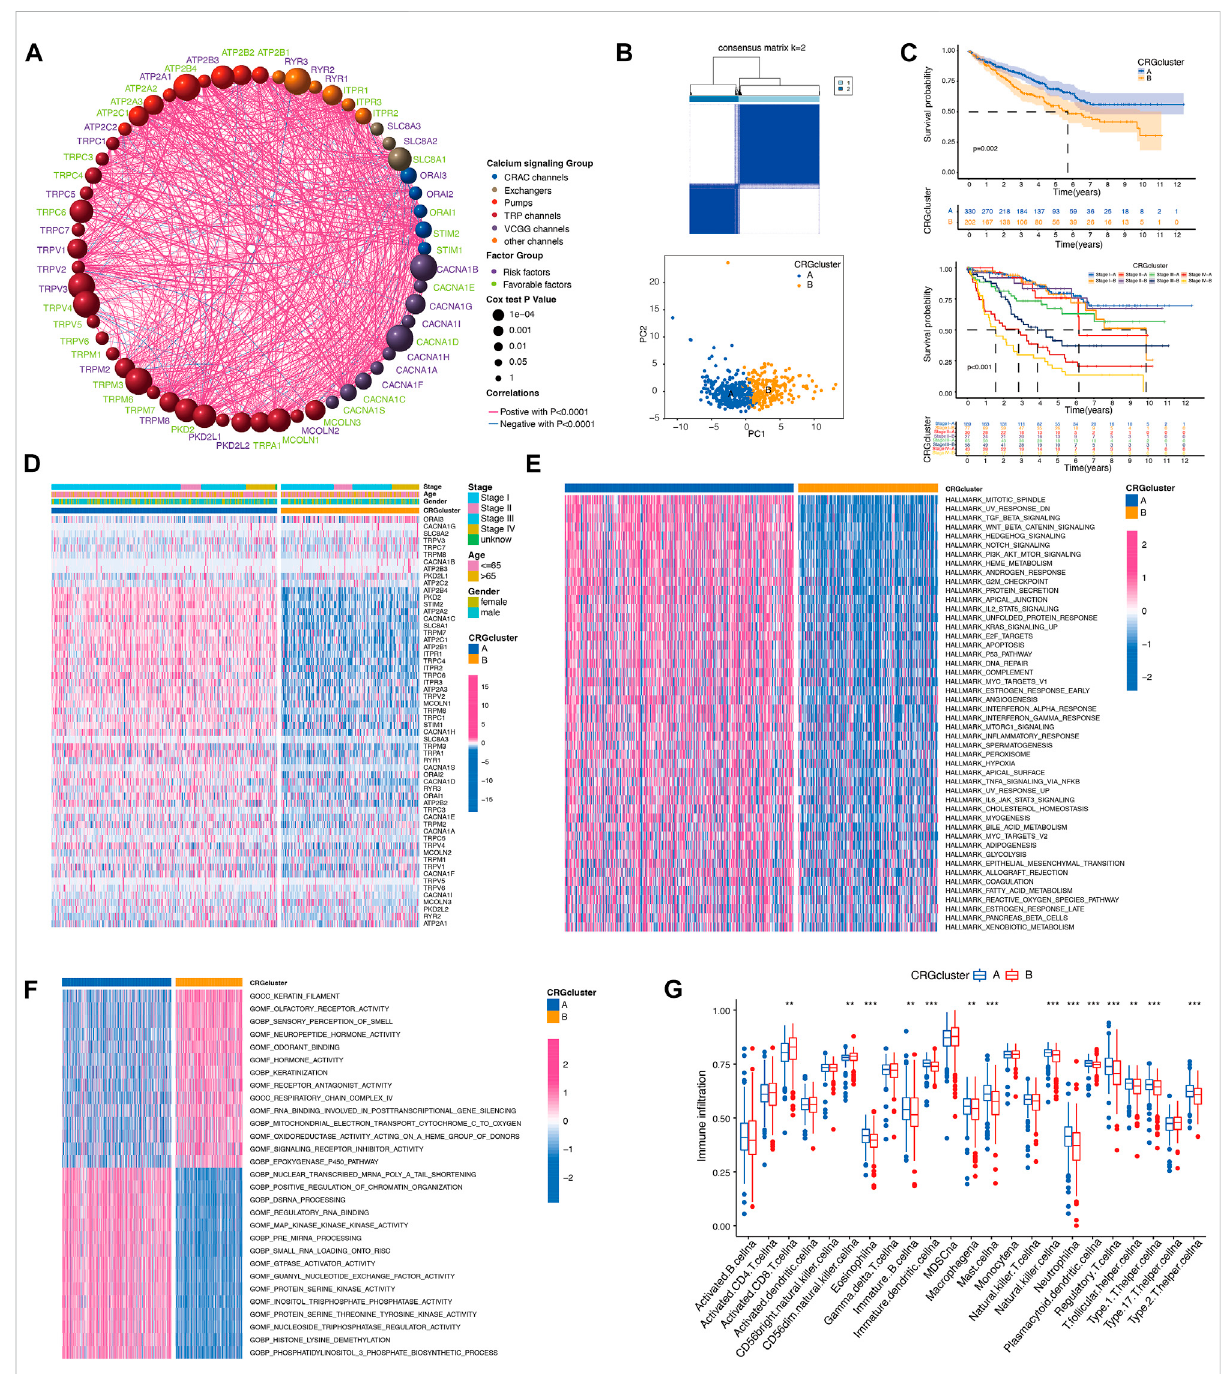
FIGURE 3 Evaluation of biological functions of CRGs. (A) The interactions between CRGs. The circle size represents the p -values of CRGs on the prognosis. Gene names with green color represent favorable factors for prognosis, and purple color represent risk factors for prognosis. The thickness of the lines represents the strength of correlation between CRGs. Negative and positive correlations were marked with blue and red, respectively. (B) TheconsensusmatrixesofKIRCsamples( k =2). (C) Kaplan – Meiercurvesshowedtheoverallsurvivalbetweencalciumclusters. (D) CRGsexpressionbetweencalciumclusters. (E,F) HALLMARKandGOsignatureenrichmentbetweencalciumclusters. (G) Immunecellin fi ltration between calcium